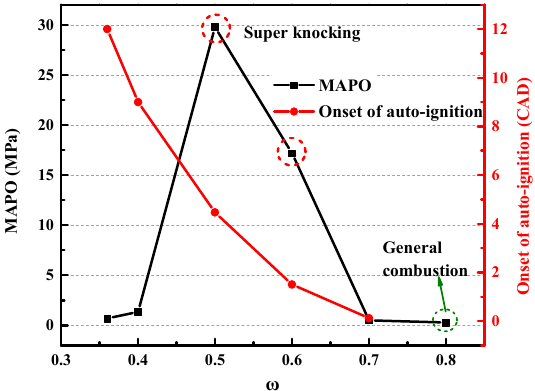
Figure 7. MAPO and onset of auto-ignition with different flame velocities.